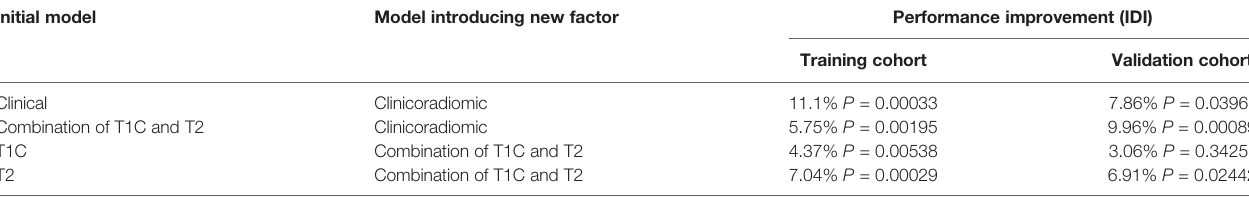
TABLE 3 | Comparison of the different models in the validation